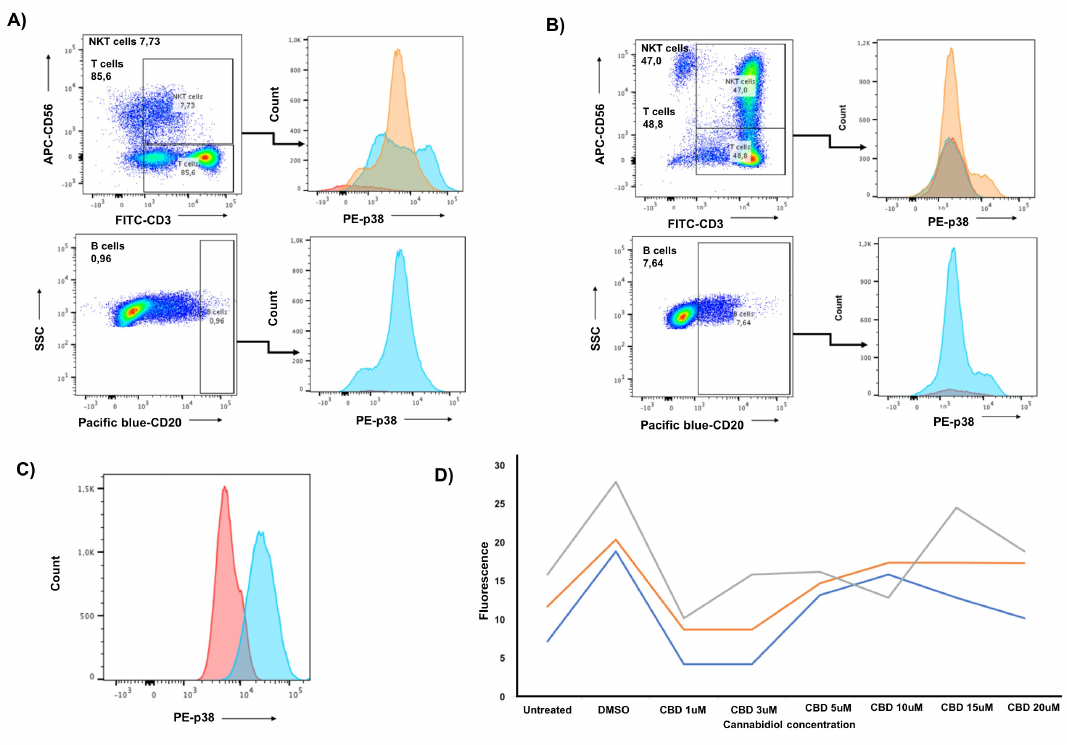
Figure 3. ( A ) The expression of p-p38 in the main cell subsets of human Cytokine-induced killer (CIK) cells, i.e., CD3 + CD56 + (NKT), CD3 + CD56 − (T cells), and CD20 + B cells. Intracellular p–p38 expression was evaluated and the CIK cells were immunophenotyped at day 7 by flow cytometry. For the subsets CD3 + CD56 + (NKT) 7.73%, CD3 + CD56 − (T cells) 85.6%, p–p38 expression (histogram representation) was 0% (red) and 3.0% (blue), respectively. The isotype is orange. For CD20 + B cells 0.96%, p–p38 expression was 0% (red). The isotype is blue. ( B ) Intracellular p–p38 expression was evaluated and the CIK cells were immunophenotyped at day 14 by flow cytometry. For the subsets CD3 + CD56 + (NKT) 47.0%, CD3 + CD56 − (T cells) 48.8%, p–p38 expression (histogram representation) was % 0 (red) and 0% (blue), respectively. The isotype is orange. For CD20 + B cells 7,64%, p–p38 expression was 0% (red). The isotype is blue. ( C ) The expression of p–p38 in PANC-1 cell line. Intracellular p–p38 expression was evaluated, and the cells were immunophenotyped by flow cytometry. Histogram dotplot with PANC–1 cells (red) and isotype (blue). P–p38 was not detectable in PANC–1 cell line via flow cytometry. ( D ) Phosphorylation of CREB in CIK cells stimulated with cannabidiol from 1 µ M to 20 µ M for 30 min at 37 ◦ C. The graph shows the mean of three independent experiments performed in technical triplicate, each with cells from a separate subject (three subjects in total). The data were